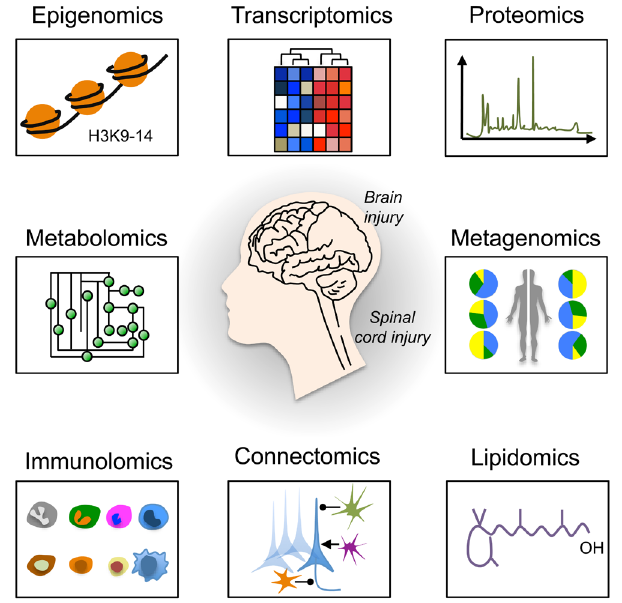
Figure 1. A multi-layer omics approach to study axon regeneration. A schematic representation of omics approaches to study axon regeneration is shown. Epigenomics studies epigenetic modifications on DNA or histone proteins that alter gene expression. DNA